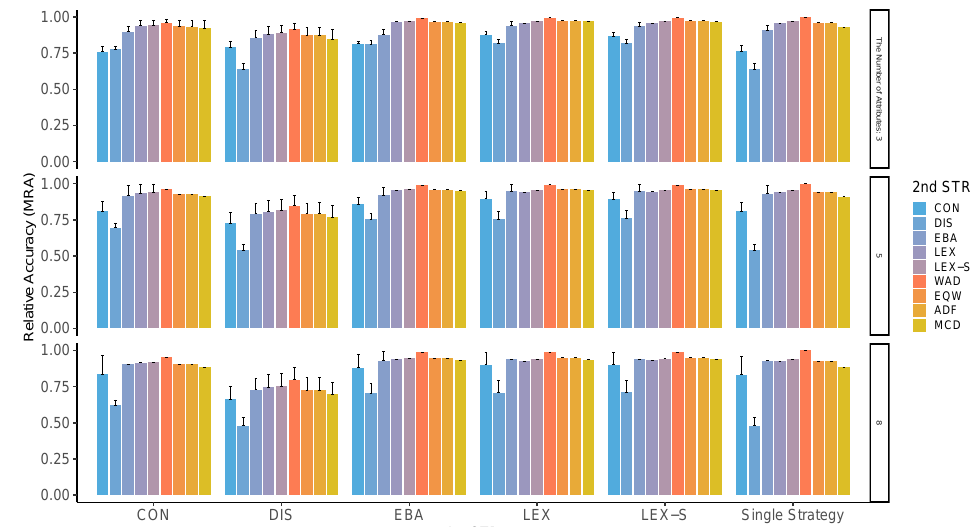
Figure A8. MRA in two-stage decision-making when three alternatives are left in the second stage for the different numbers of attributes. Note: ADF: additive difference; CON: conjunctive; DIS: disjunctive; EBA: elimination by aspects; EQW: equal-weighted strategy; LEX: lexicographic; LEX-S: lexicographic semi-order; MCD: majority of confirming dimensions; STR: strategy; WAD: weighted